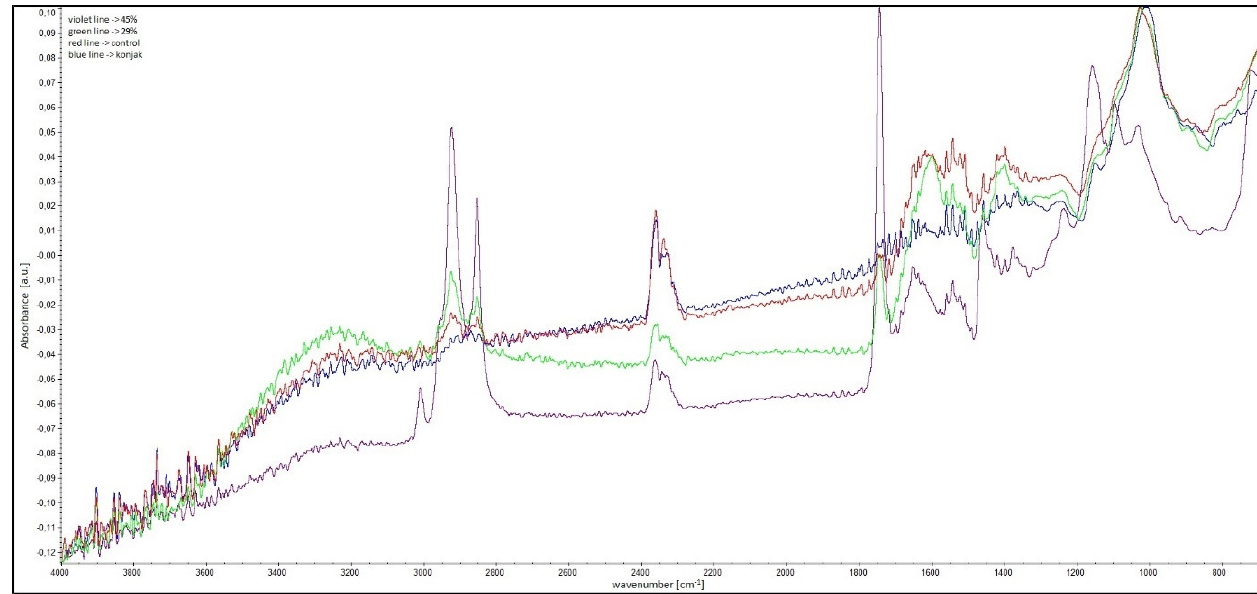
Figure 1. FT-IR analysis of hydrogels with encapsulated safflower oil.